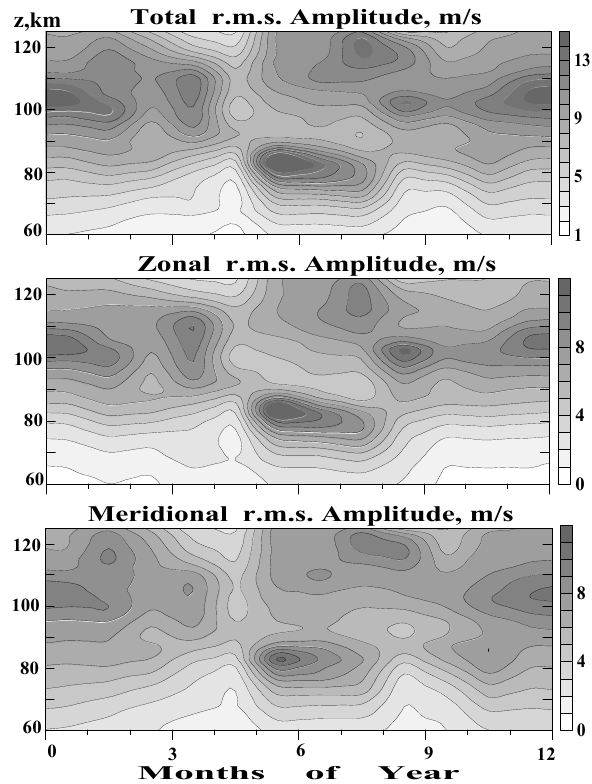
Fig. 3. Calculated seasonal-altitude distributions of standard devia- tions of total (upper), zonal (middle) and meridional (bottom) wind Fig. 3. “Gavrilov and Jacobi, A study of seasonal…” speed produced by the set of harmonics modeling IGW